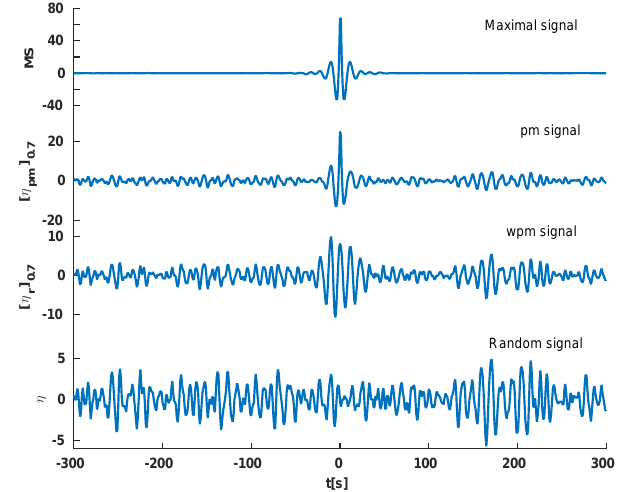
Figure 2. Shown are plots from up to down of a maximal, pseudo- maximal and weak pseudo-maximal signal corresponding to the same random signal at the bottom. The random signal corresponds to a Jonswap spectrum with H s = 6 . 3m and γ = 1.9. The pm and wpm signals correspond to the value α =